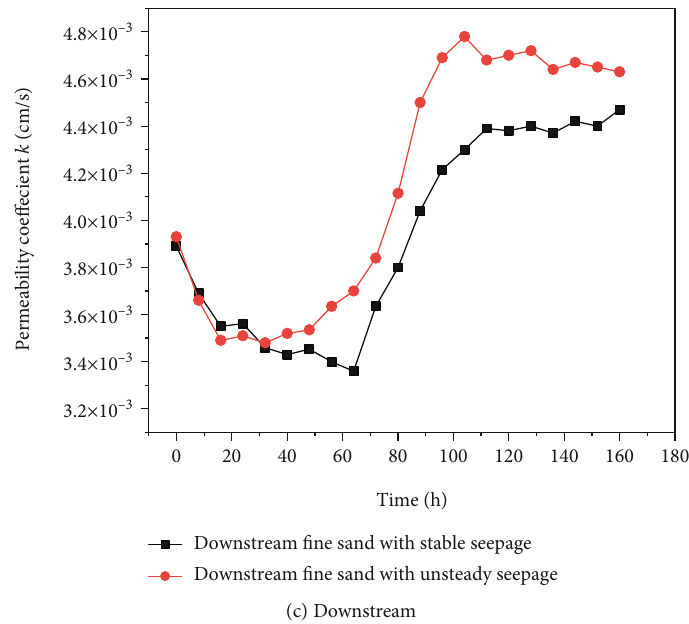
Figure 10: Comparison of unsteady seepage and stable seepage permeability coe ffi